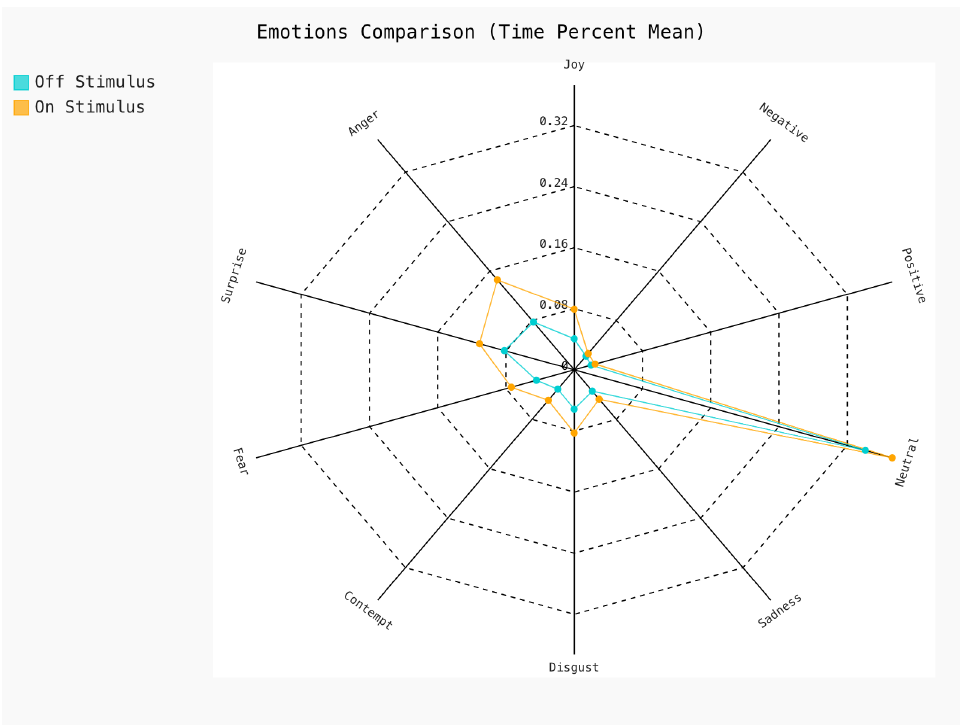
Figure 9. Comparison of the mean of the percentage of observable time for each emotion between dynamic web design—on-stimulus—and static web design—off-stimulus.